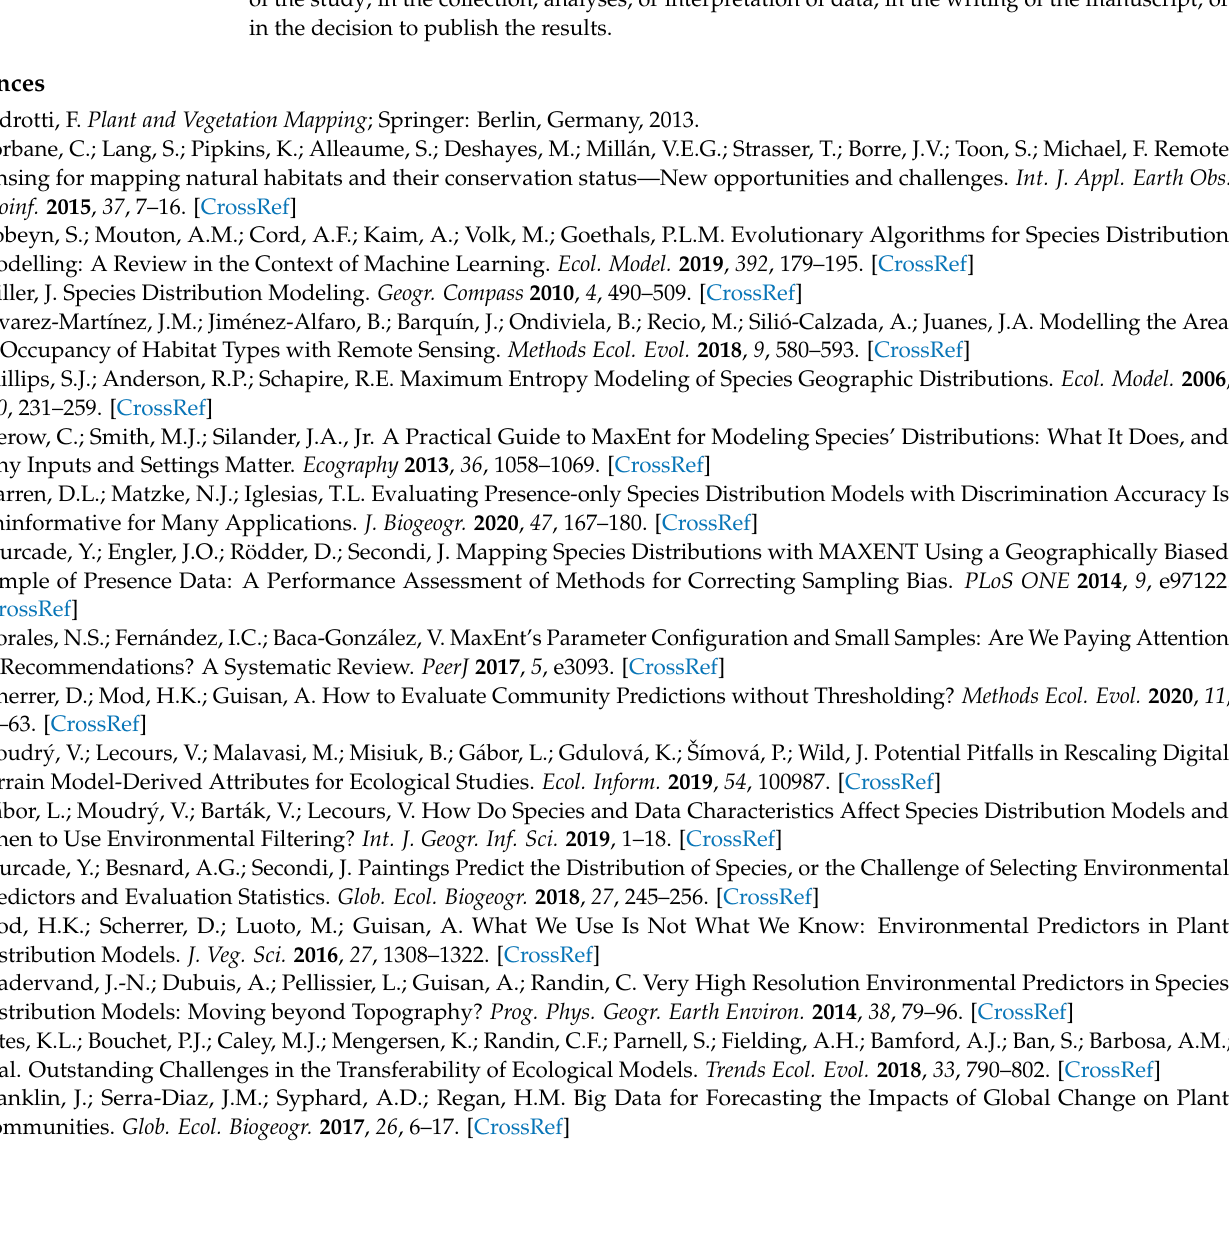
Table S3: Categories and questions used to analyze the selected